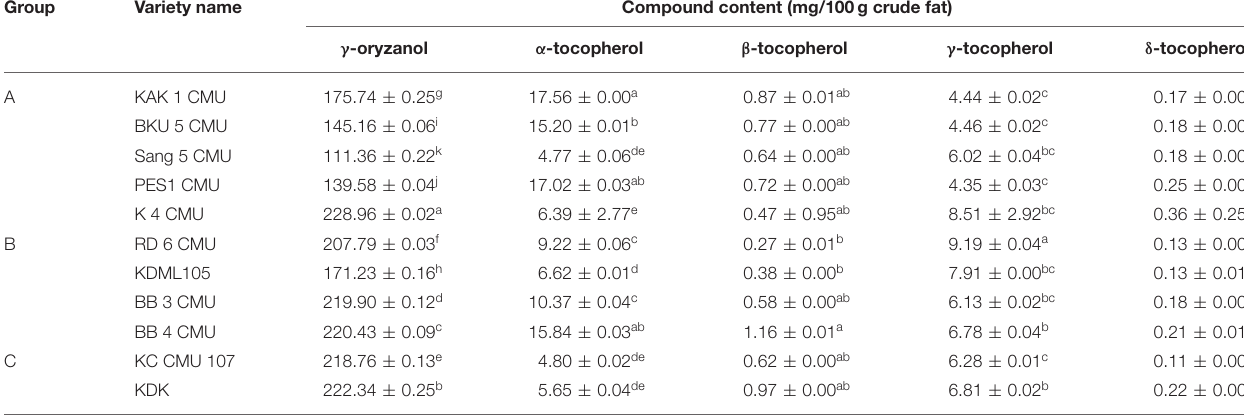
All values are mean ± SD. Values followed by different superscript letters in the same row are significantly different (P < 0.05).